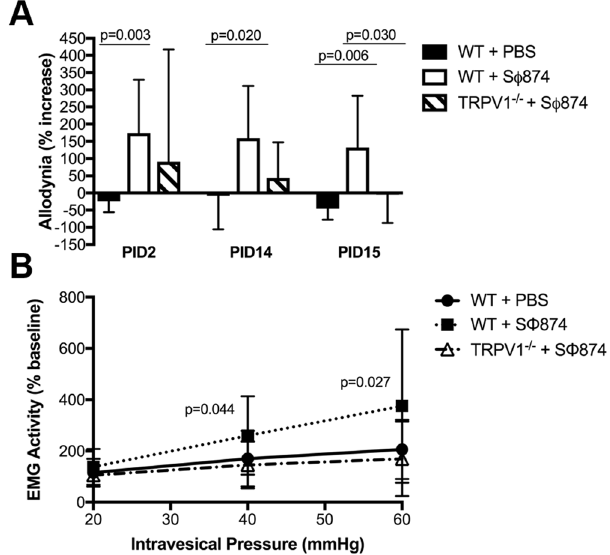
Figure 2. TRPV1-deficient mice do not develop post-UTI chronic pain. Values represent mean ± S.D. ( A ) Female WT or TRPV1 − / − mice were instilled with saline or E. coli strain S Φ 874, and mechanical allodynia was quantified on PID 2, PID 14, and PID 15. S Φ 874 induced significant allodynia in WT mice (n = 8, P < 0.05) relative to saline-treated mice (n = 8), whereas TRPV1 − / − S Φ 874-treated mice did not (n = 7). ( B ) VMR in response to bladder distension with saline at PID 15 after instillation of S Φ 874 or PBS. Relative to saline-treated wild type mice, S Φ 874 induced increased EMG activity in wild type mice that was not induced in TRPV1 − / − mice (n = 5, * P < 0.05).